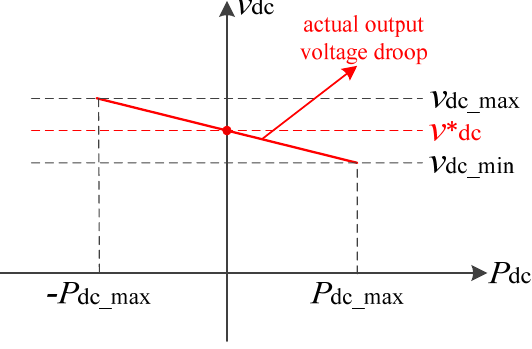
Figure 3. Droop control diagram at the DC